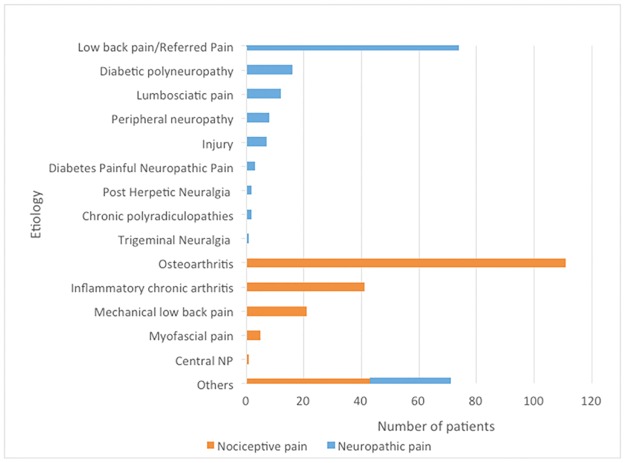
Etiology of pain in the two study groups.